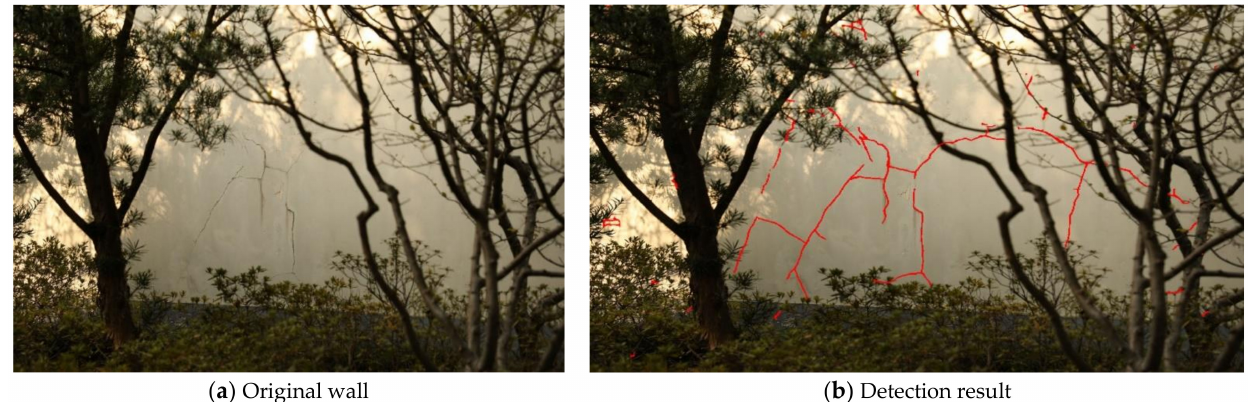
Figure 14. Detection of cracks on wall with interference